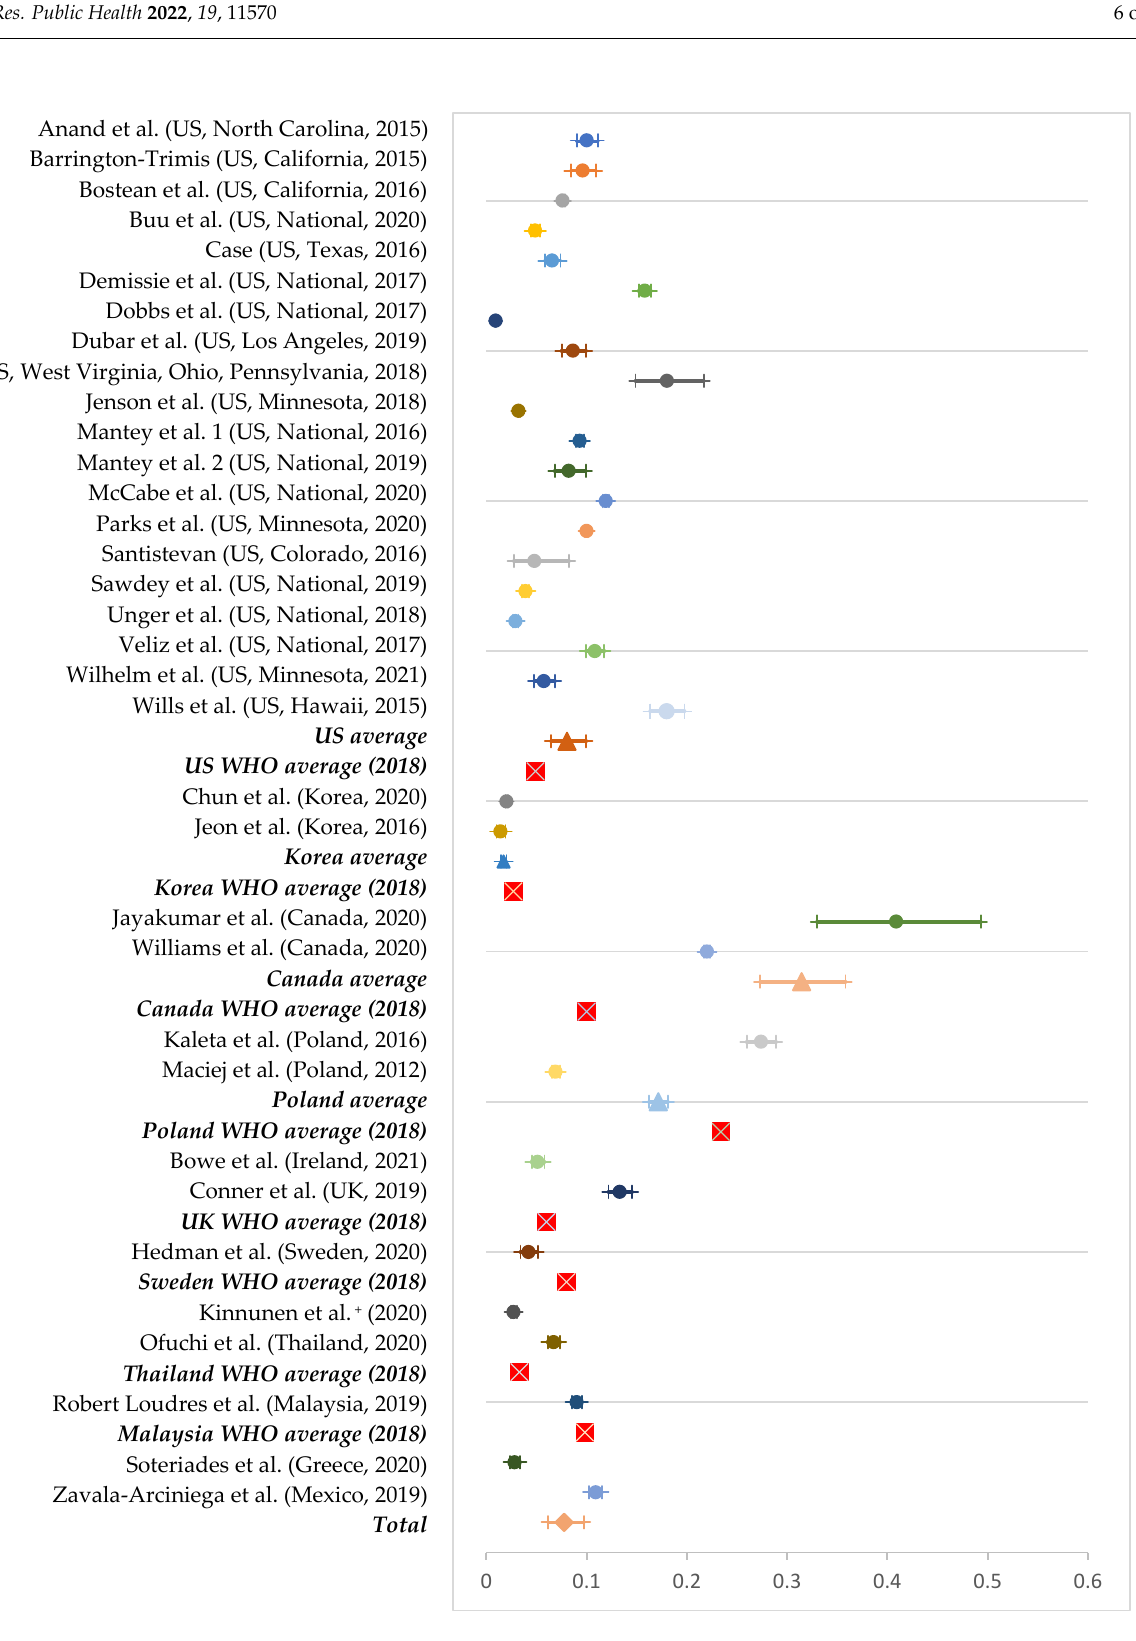
Figure 3. Prevalence of current e-cigarette use by country [11,23,27–30,40,41,43,44,46,48–52,54–57,59,62,63,65–68,70,73,74,77–80]. Note 1. + Includes 6 European countries (Belgium, Finland, Germany, Ireland, Italy, The Netherlands, Portugal). Note 2. National average is presented with the shape of a triangle, WHO average as a red box marked with ‘X’, and the total pooled prevalence as